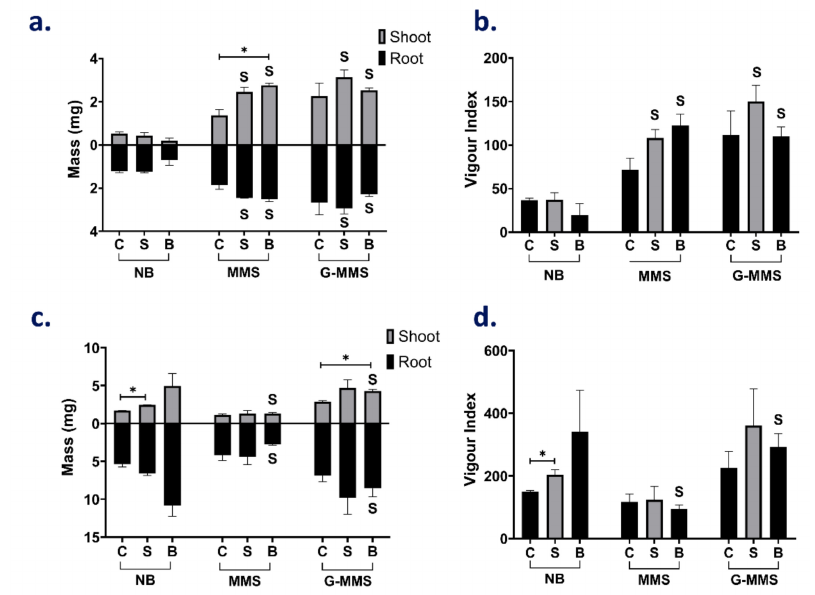
Figure 6. Effect of SOS3 on biomass and vigour of sorghum ( Sorghum bicolor L.) and maize ( Zea mays L.). Dry biomass ( a ) and vigour index ( b ) of sorghum seeds. Dry biomass ( c ) and vigour index ( d ) of maize seeds. Seeds were treated with sterile media control (C), SOS3 supernatant (S), or SOS3 bacterial culture (B). Three media were tested: NB, MMS, and G-MMS. Each treatment had four replicates. Measurements were performed 5 days after germination. Significance was calculated using standard t -tests. For simplicity, significance was only tested between relevant groups (i.e., between the three treatments of each medium, the three controls, the three supernatant treatments, and the three bacteria treatments). S represents significance compared to the corresponding treatment of at least one other media type (only shown on MMS and G-MMS). Levels of significance are not noted in either the S or * labels. SOS3 cultures also exhibited growth-promoting effects on maize seeds (Figure 5c,d); however, the results do not follow the same behaviour as in sorghum. For maize seeds, SOS3 cultures grown on MMS medium showed a lower dry mass in roots and shoots compared to NB and G-MMS media. Similarly, MMS conditions displayed a lower vigour index compared to NB and